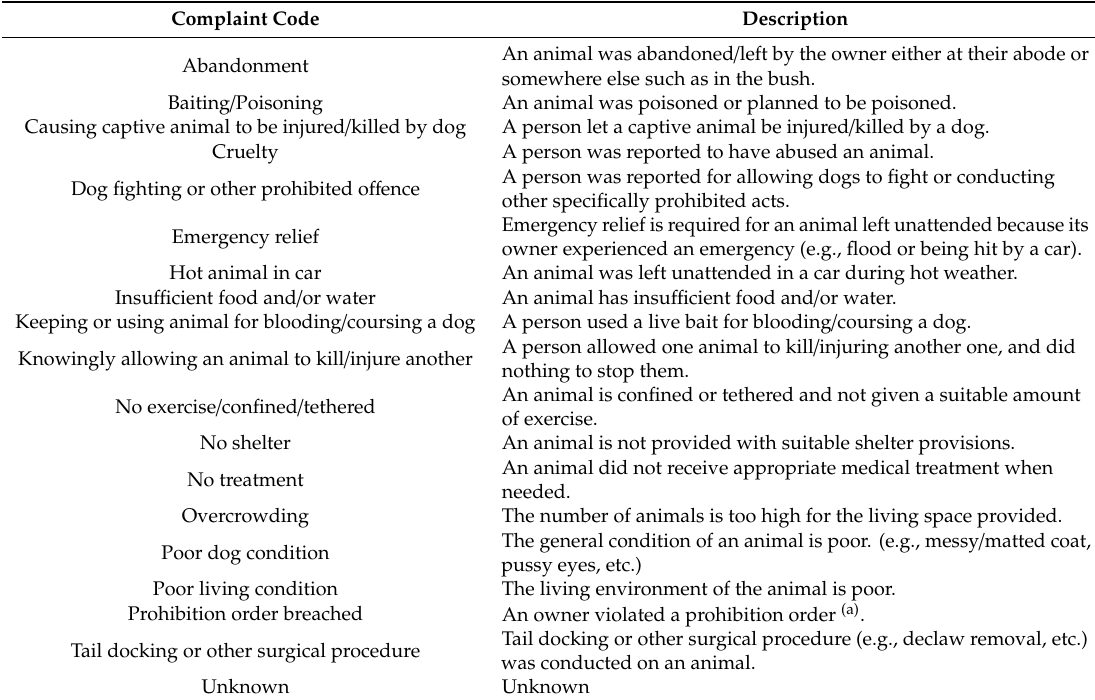
Table A1. Description of each complaint code alleging a welfare